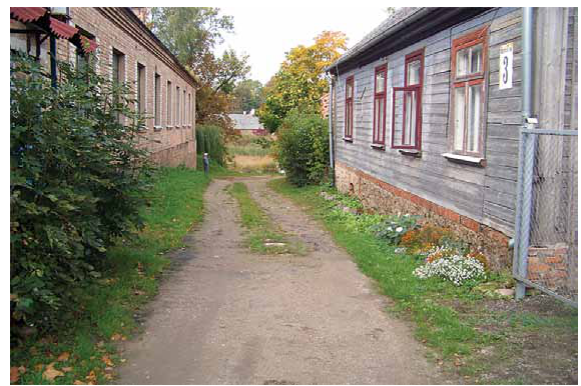
Fig. 8. The historical buildings and character of nature near the bank of the Mēmele. Source: 2012, author’s photo.